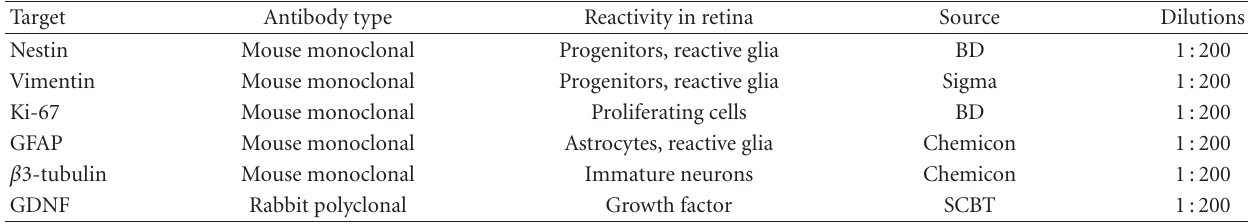
Table 1: Primary antibodies used for immunocytochemistry on